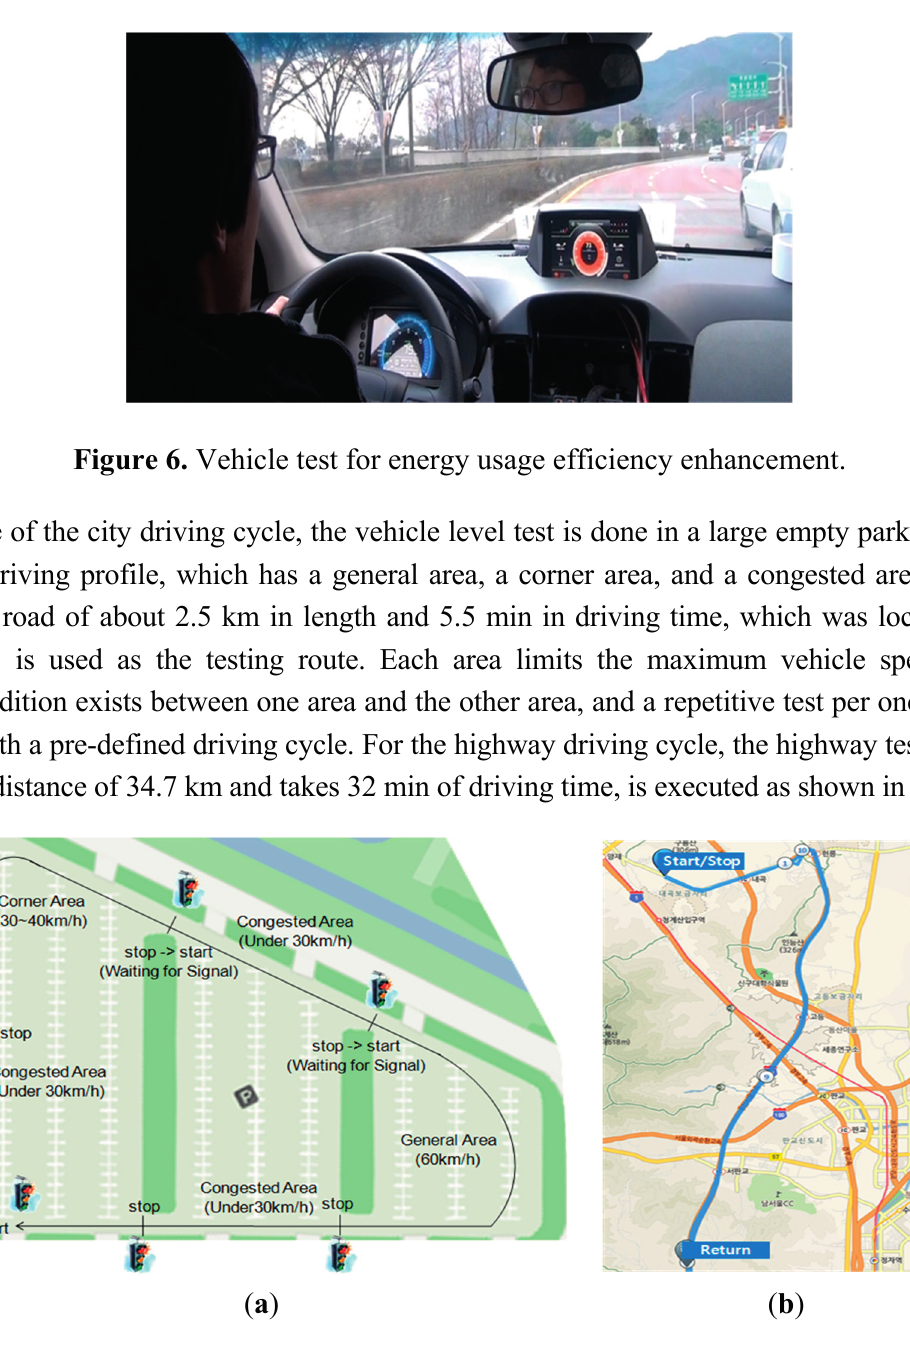
Figure 7. ( a ) City driving cycle; ( b ) Highway driving